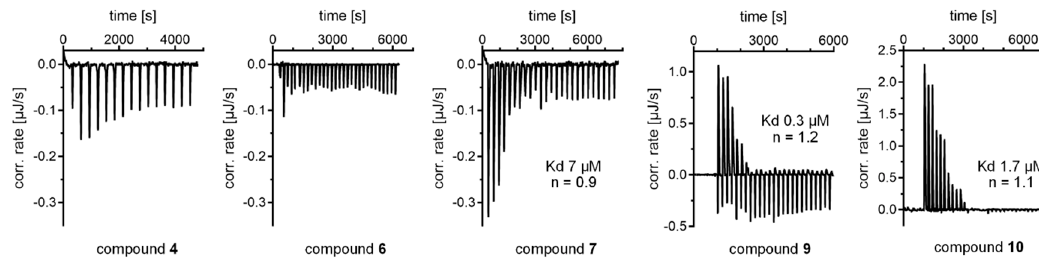
Figure 4. Isothermal titration calorimetry (ITC) demonstrated binding of 7 , 9 , and 10 to the recombinant HNF4 α LBD protein, confirming their HNF4 α -mediated activity. Recombinant HNF4 α LBD protein (10–20 µM) was titrated with ligands (50–200 µM).